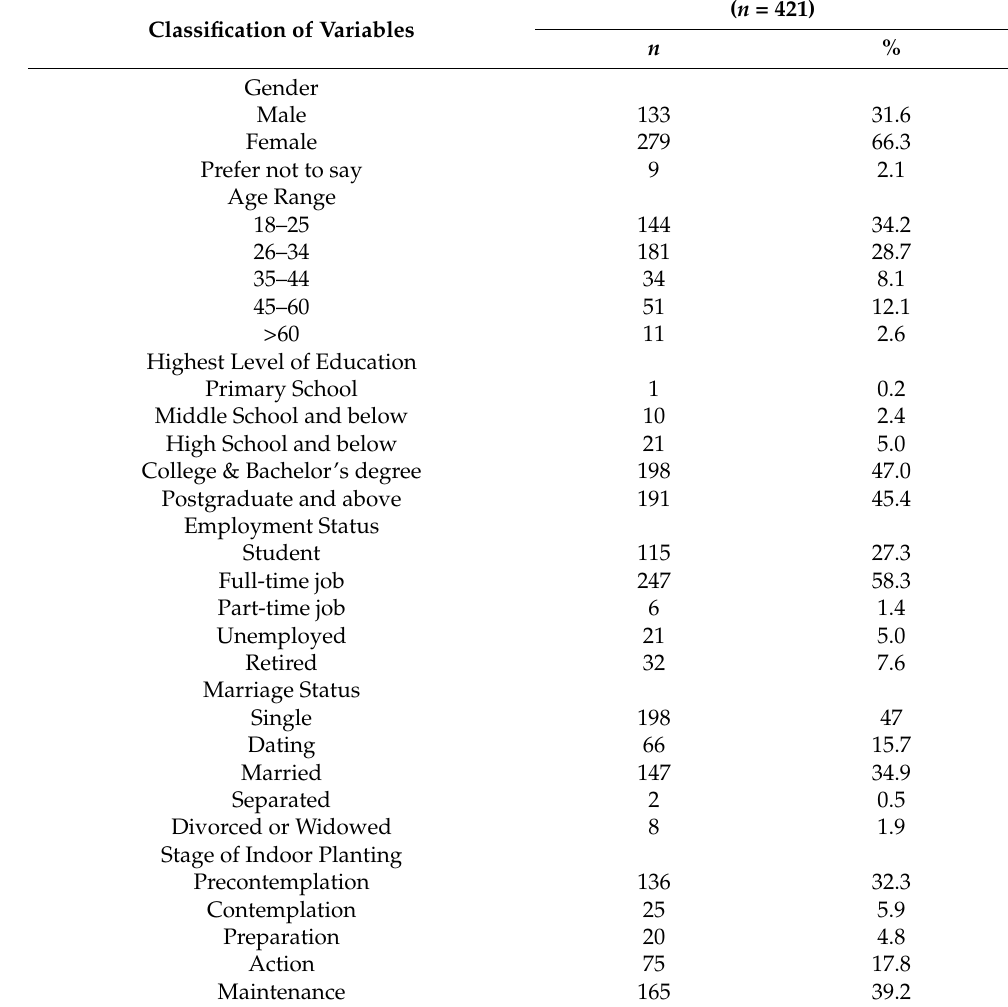
Table 1. Sample demographic